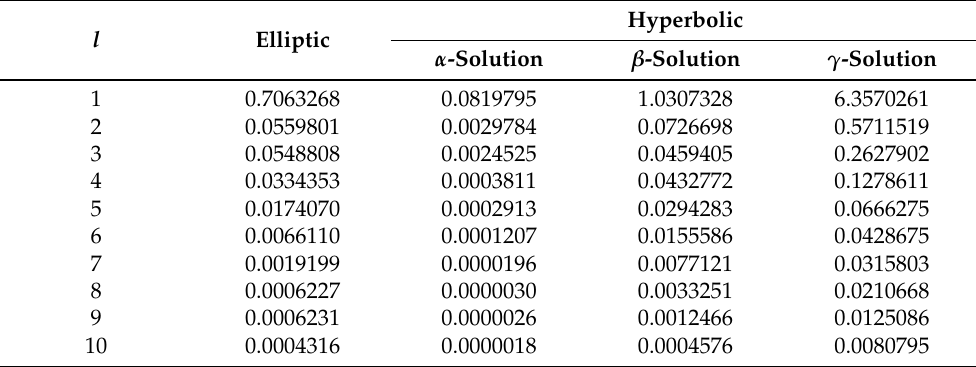
√ Table 4. The MSE of polynomial regression method of orders l = 1, . . . ,10 in estimating the critical ( z ) − z 2 in elliptic and hyperbolic cases based on a training collapse response function g ( z ) = b 2 0 sample of size n = 100.